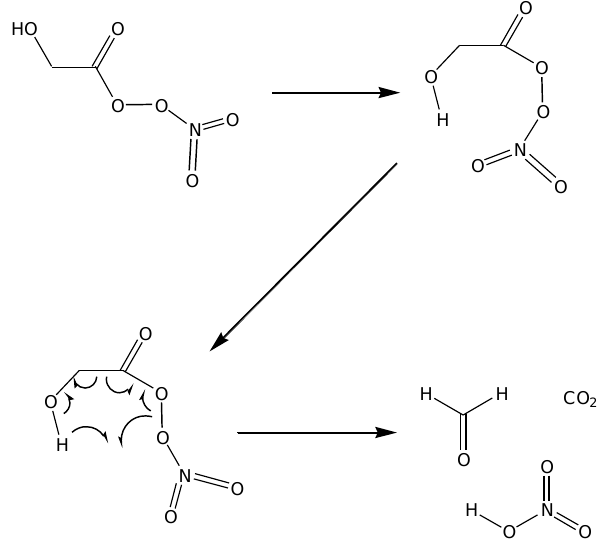
Fig. 11. Possible unimolecular thermal dissociation pathway for